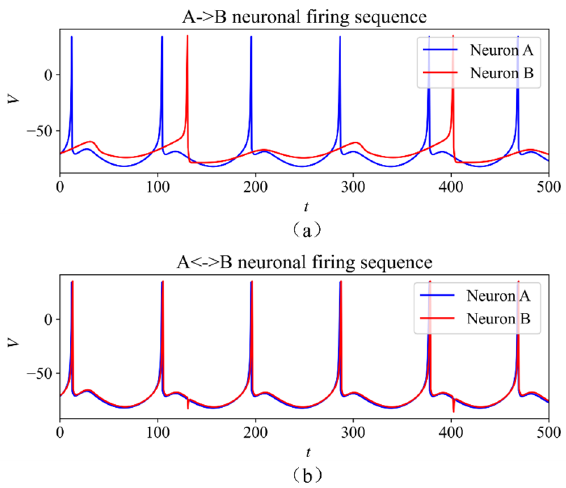
Figure 2. Two neuronal discharge sequences (a) Neurons A and B are unidirectional coupling; (b) Neurons A and B are dual coupling.).